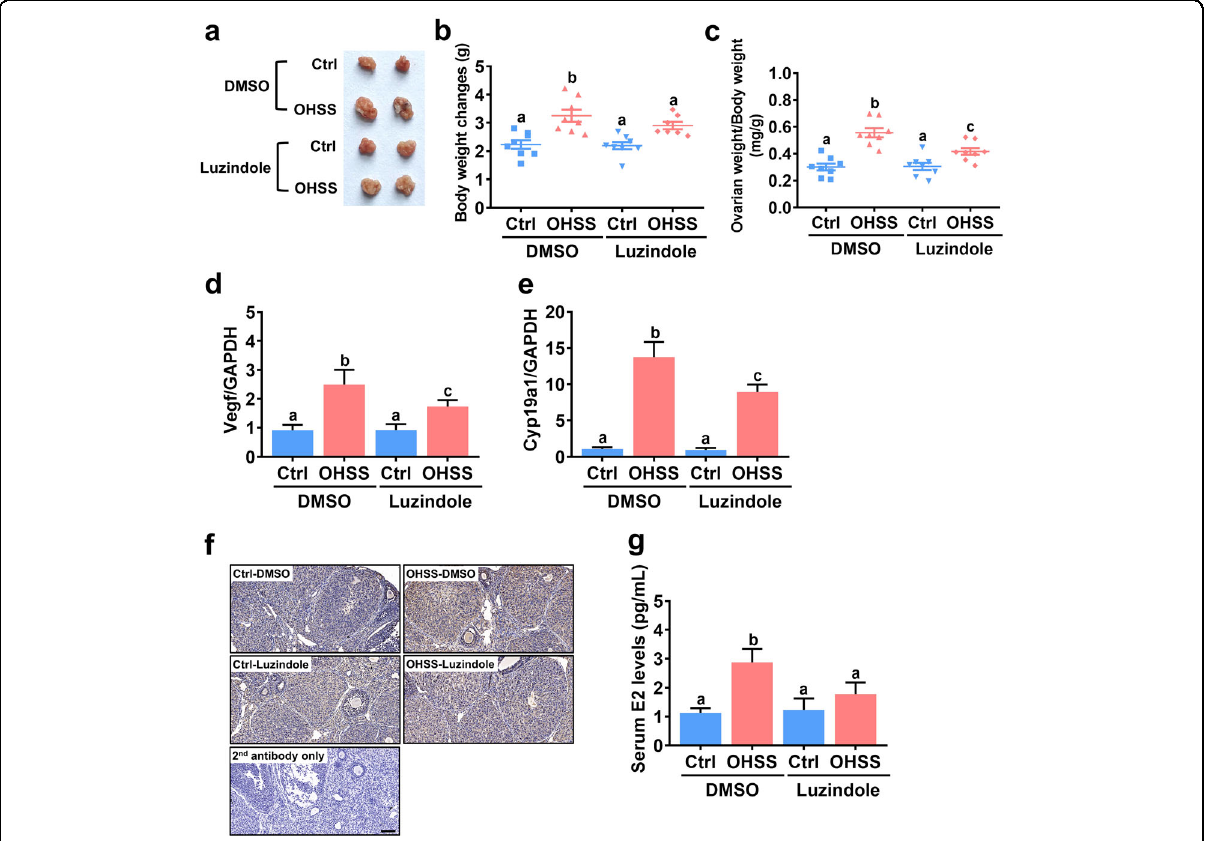
Fig. 4 Blocking melatonin signaling inhibits the development of OHSS. a Representative ovaries of mice from each group were photographed. b Changes in body weight throughout the treatment period were evaluated after the mice were euthanized. c Ovarian weight relative to body weight was analyzed after the mice were euthanized. d , e The mRNA levels of VEGF ( d ) and aromatase (Cyp19a1) ( e ) in mouse ovaries were examined by RT-qPCR. f Representative images of immunostaining for aromatase in ovarian sections. Original magni fi cation: ×200. The scale bar represents 50 μ m. g The serum E2 levels in mice were examined by ELISA. The results are expressed as the mean ± SEM of at least three independent experiments. Values without a common letter are signi fi cantly different ( p <